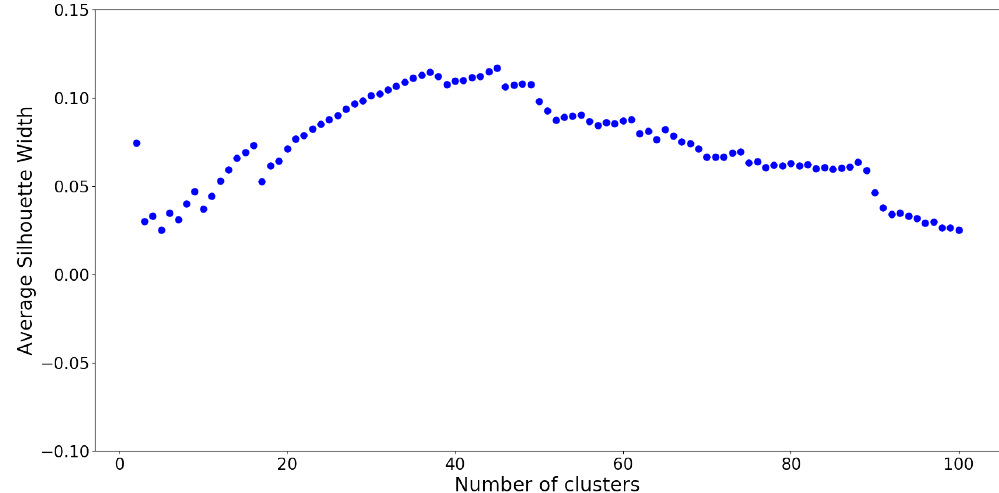
Figure 9. Silhouette numbers for clusters 2 < K < 100. The highest value of 0.117 occurs at K = 45.